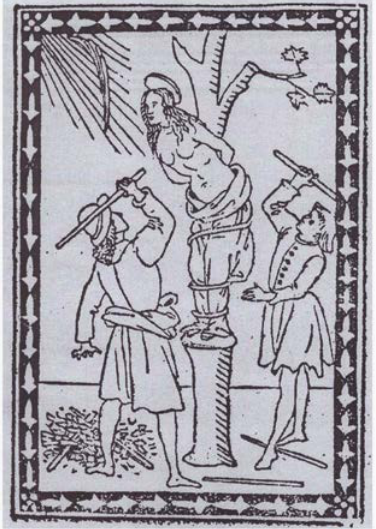
Figure 23 – La Rapresentatione di Sancta Agata Vergine & Martyre , ad instantia di ser Piero Pacini da Pescia, s.l.a. [but Firenze, Bartolomeo de’ Libri, around 1496?], f. b1r (BNCF, Banco Rari 179.8). By permission of Ministero per i beni e le attività culturali / Biblioteca Nazionale Centrale.